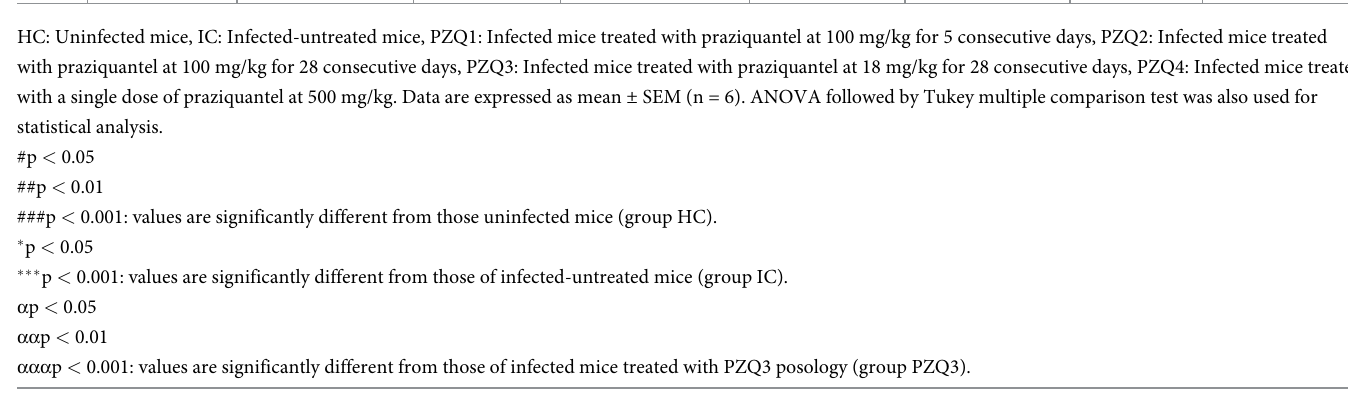
did not restore erythrogram, leucogram, and platelet count similar to those of the HC group. The efficacy of the PZQ2 scheme of treatment was observed in the granulomatous phase only (Table 4).